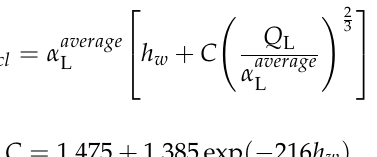
Figure 7. Clear liquid height as a function of the weir height. U S = 0.65 m/s, Q L /L w = 20 m 3 /(m·h). 3.2. Gas–Liquid Phase Fraction Distribution 3.2.1. Liquid Phase Fraction Distribution After the convergence of the simulations, the liquid phase fraction distribution in the x – y section at z = − 27.5 mm for the rectangular guided valve and parabolic–shaped